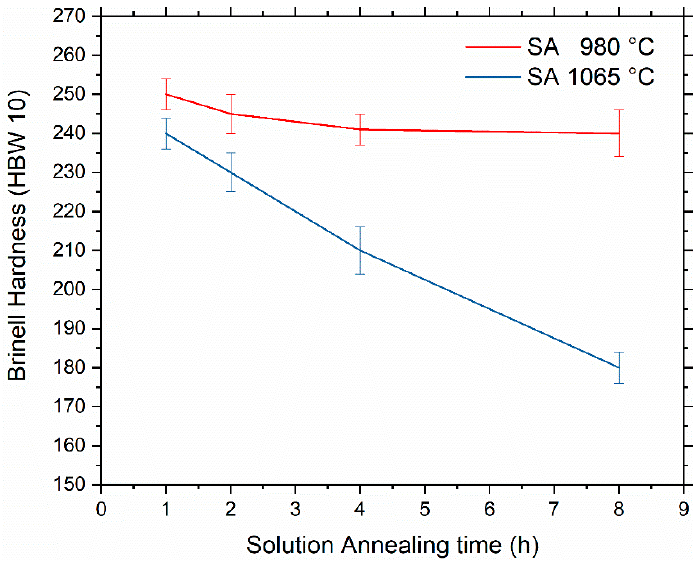
Figure 6. Brinell hardness as a function of solution annealing time at two different temperatures.